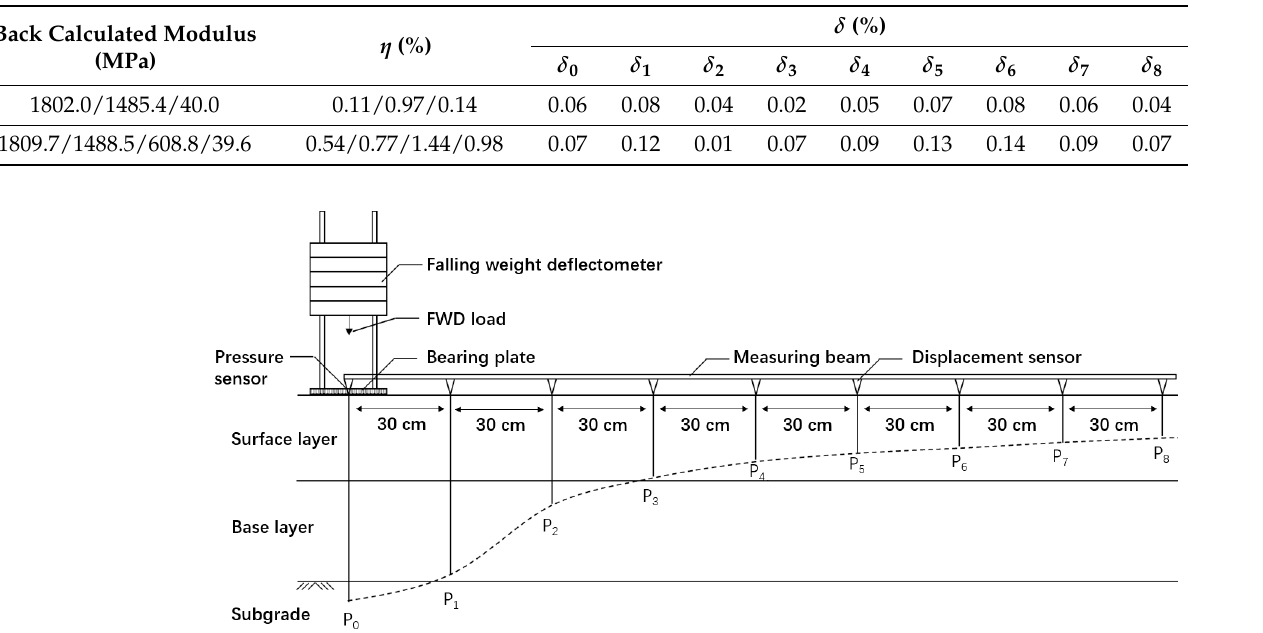
Figure 4. The distribution of deflection curve measuring points. Table 3. The theoretical deflection curves calculated in BISAR3.0.